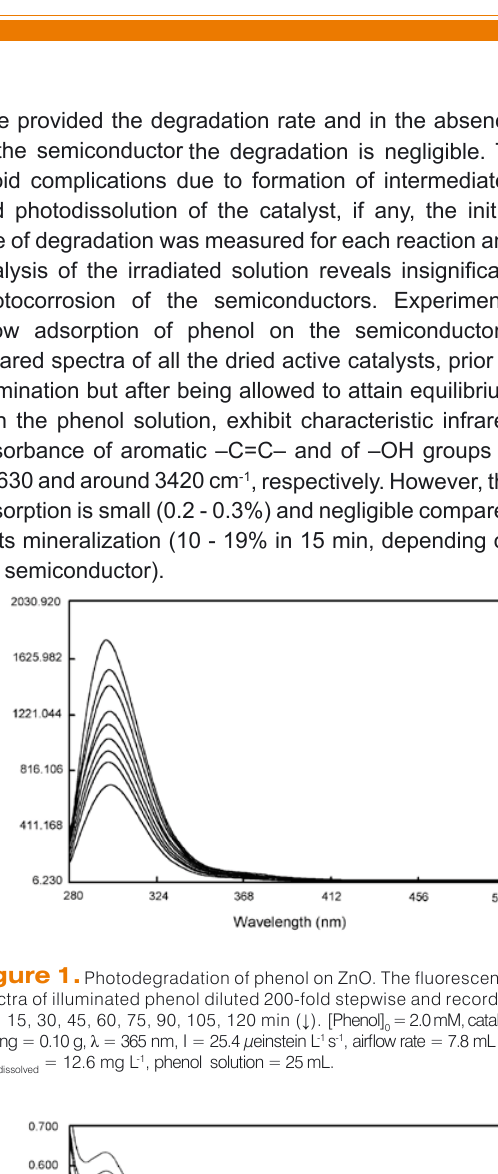
= 2.0 mM, catalyst 0